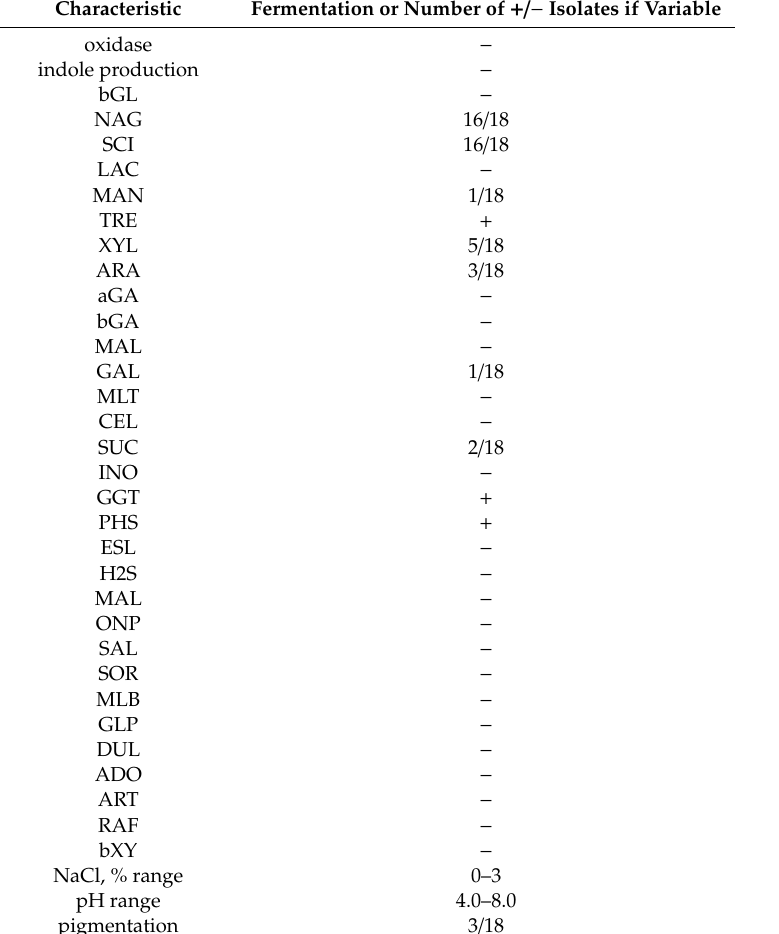
Table 2. Biochemical properties of C. vaccinii isolated